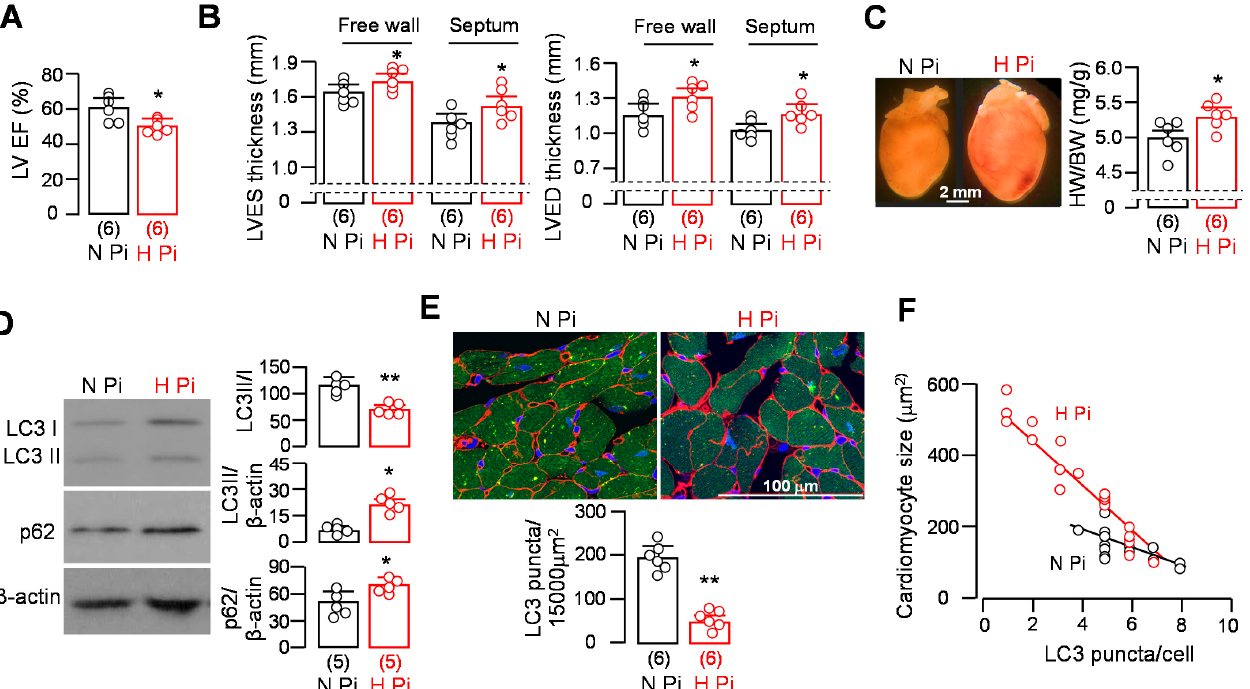
Figure 1. High phosphate caused cardiac remodeling and dysfunction and low autophagy activity in the hearts of WT mice. WT mice ( A – D ) or GFP-LC3 reporter mice ( E and F ) were fed normal- (N Pi) or high-phosphate (H Pi) diet for 12 weeks. After 12 weeks, mice were subjected to cardiac MRI for evaluation of cardiac function ( A ) and morphometry ( B ) followed by euthanization for heart histology study ( C ) and immunoblots ( D ). ( A ) Left ventricular ejection fraction; ( B ) left ventricular wall thickness at systole (left panel) and diastole (right panel); ( C ) heart hypertrophy in mice fed with high dietary phosphate. Left panel: representative gross appearance of heart. Right panel: heart weight/body weight. ( D ) Changes in autophagic markers in the heart. Left panel: representative immunoblots for LC3 and p62 in left ventricular lysates. Right panel: a summary of all immunoblot data. ( E ) Autophagic activity in the hearts of GFP-LC3 reporter mice. Four hours prior to sacrifice, mice were treated intraperitoneally with chloroquine (50 mg/Kg body weight). Left panel: representative micrographs of GFP-LC3 immunofluorescence puncta in free walls of left ventricles. Right panel: semi-quantitation of GFP-LC3 puncta. Sample number in each group is in brackets underneath the corresponding bars. Quantitative data are presented as mean ± SD with scatter plots of individual data points, and statistical significance was assessed by unpaired Student’s t -test. Significant differences are accepted when * p < 0.05 or ** p < 0.01 between two groups. ( F ) Correlation between cardiomyocyte size and the number of LC3 puncta in the hearts of LC3 reporter mice treated with normal (black symbols) or high (red symbols) dietary phosphate. The number of LC3 puncta in one heart section was counted in three locations (up, middle, and bottom) of the free wall of left ventricle; therefore, 6 mice gave 18 datasets in either the normal- or high-phosphate-fed